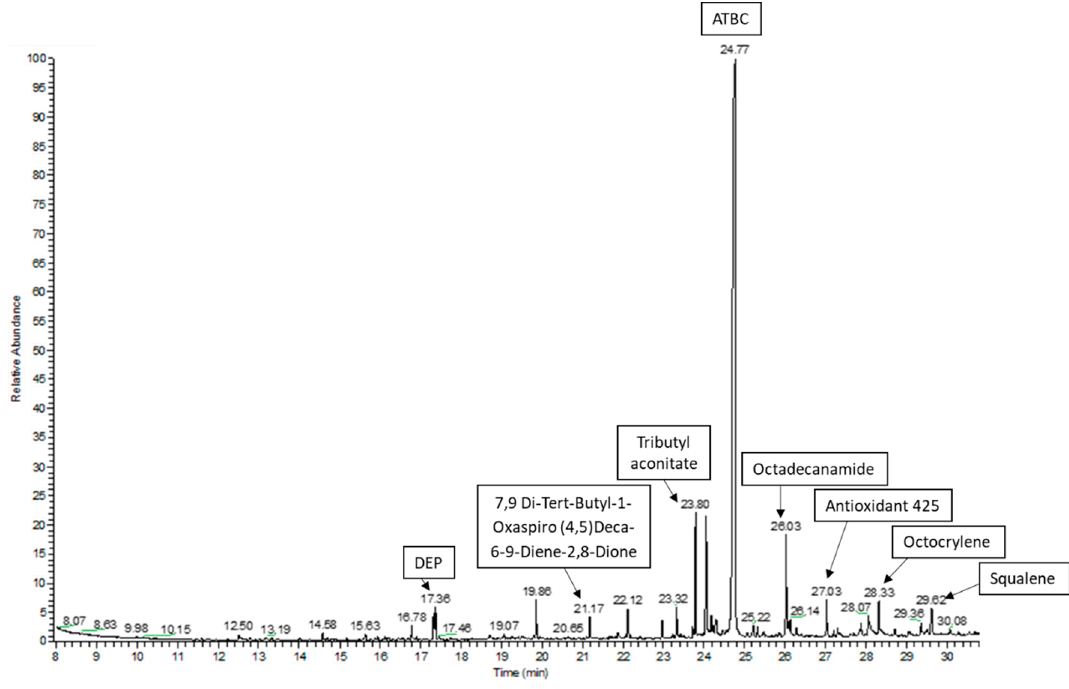
Figure 1. GC–MS chromatogram of the acetonitrile extraction in the sample GA_02.